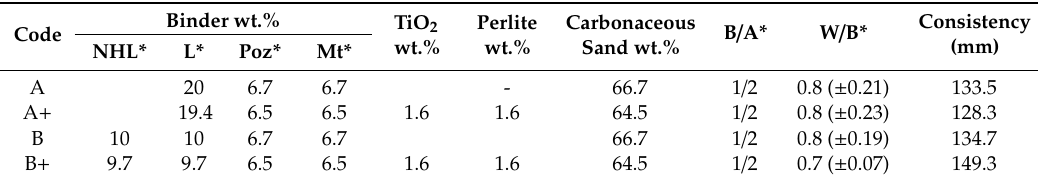
Table 1. Mortars mix